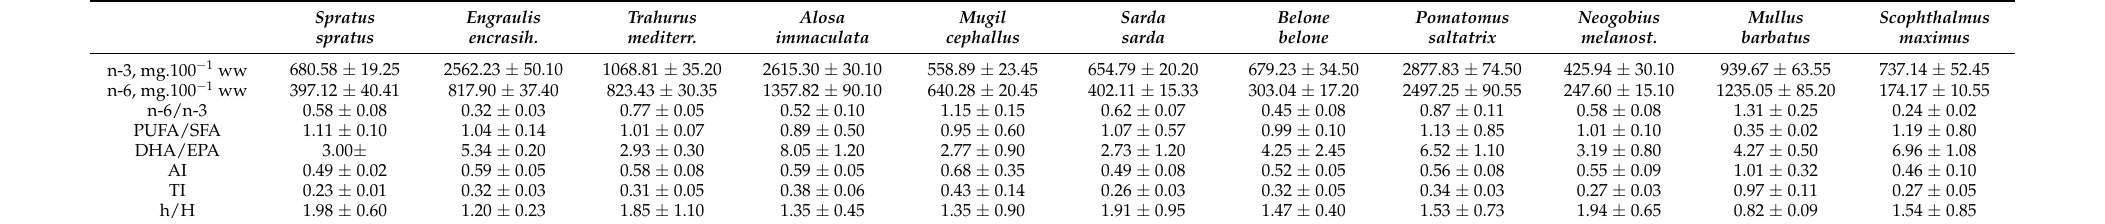
Table 3. Nutritional quality indexes of 11 fish species from the Black